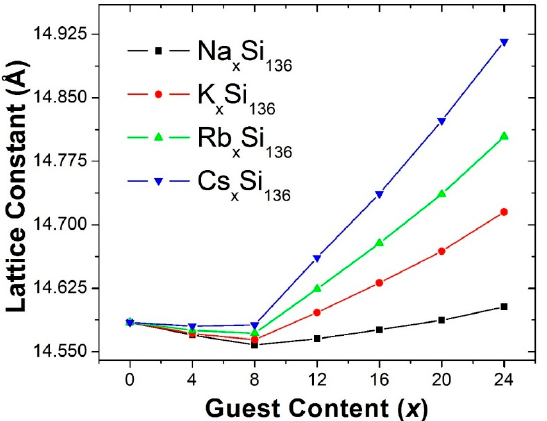
Figure 1. Predicted x Dependence of the Lattice Constants for the Type II Clathrate-Based Compounds. A x Si 136 (A = Na, K, Rb, Cs; 0 ≤ x ≤ 24). A x Si 136 (A = Na, K, Rb, Cs; 0 ≤ x ≤